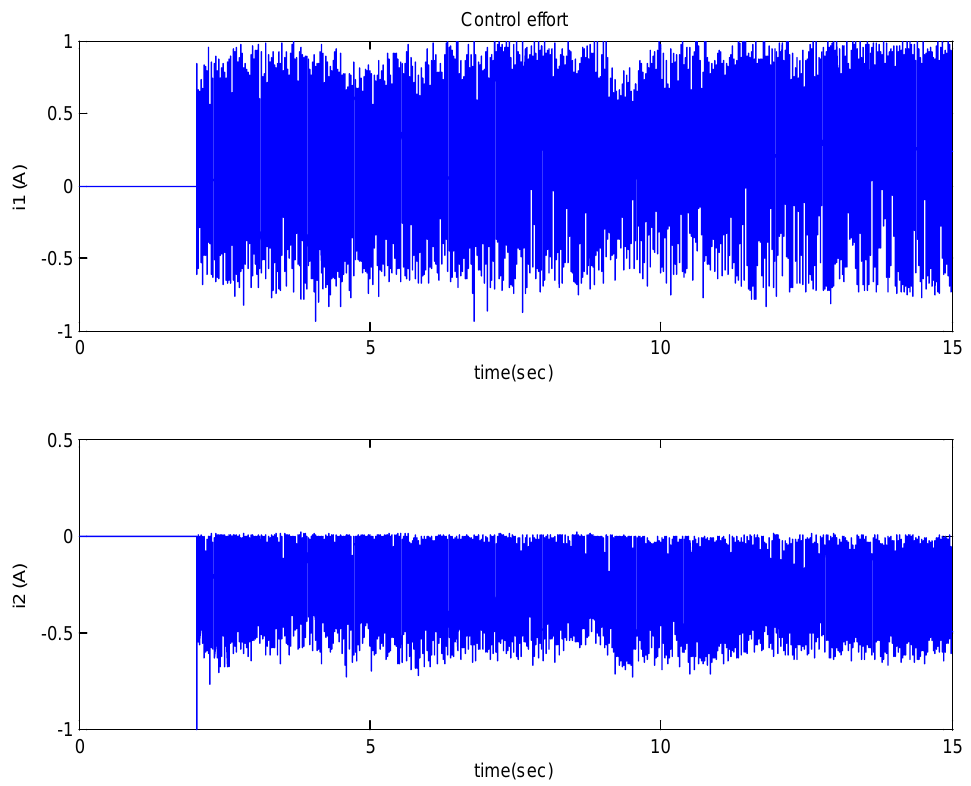
Figure 9. Experimental result: the control currents.